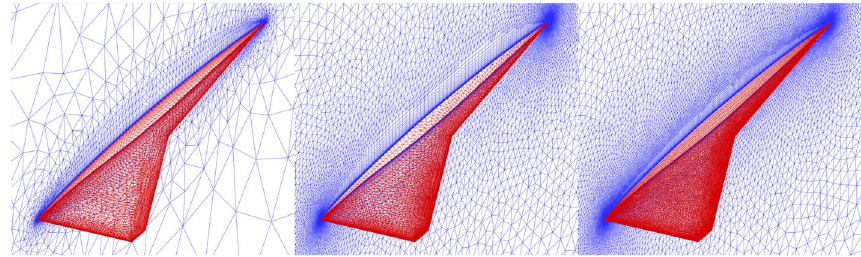
Fig. 10 The surfaces of the coarse (left), medium (middle), and fine (right)